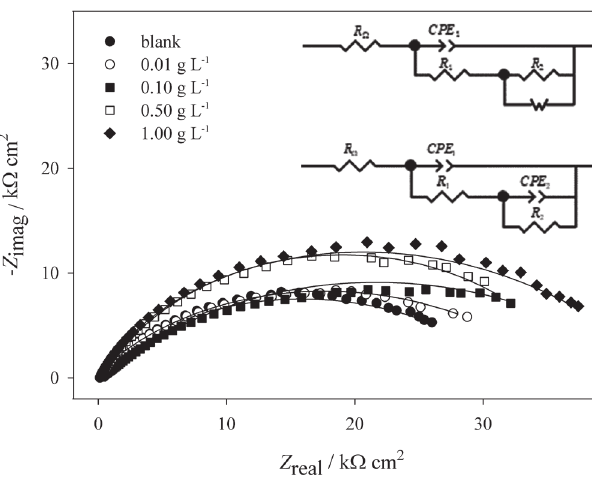
Fig. 6 – Impedance spectra (Nyquist plot) of the Cu elec­ trode recorded at E